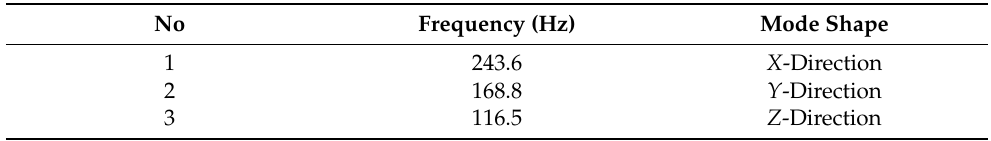
Figure 10. First three-order natural frequencies of the separation mechanism. Table 5. Modal analysis results of separation Table 4. Modal analysis results of the combination.